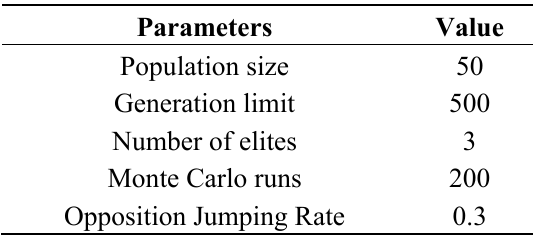
Table 1. Simulation settings for TSP problem.